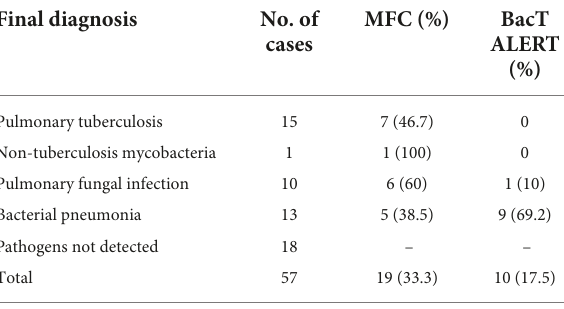
TABLE 4 Results of BacT/ALERT culture and BD BACTEC TM culture ( n = 57). Final diagnosis